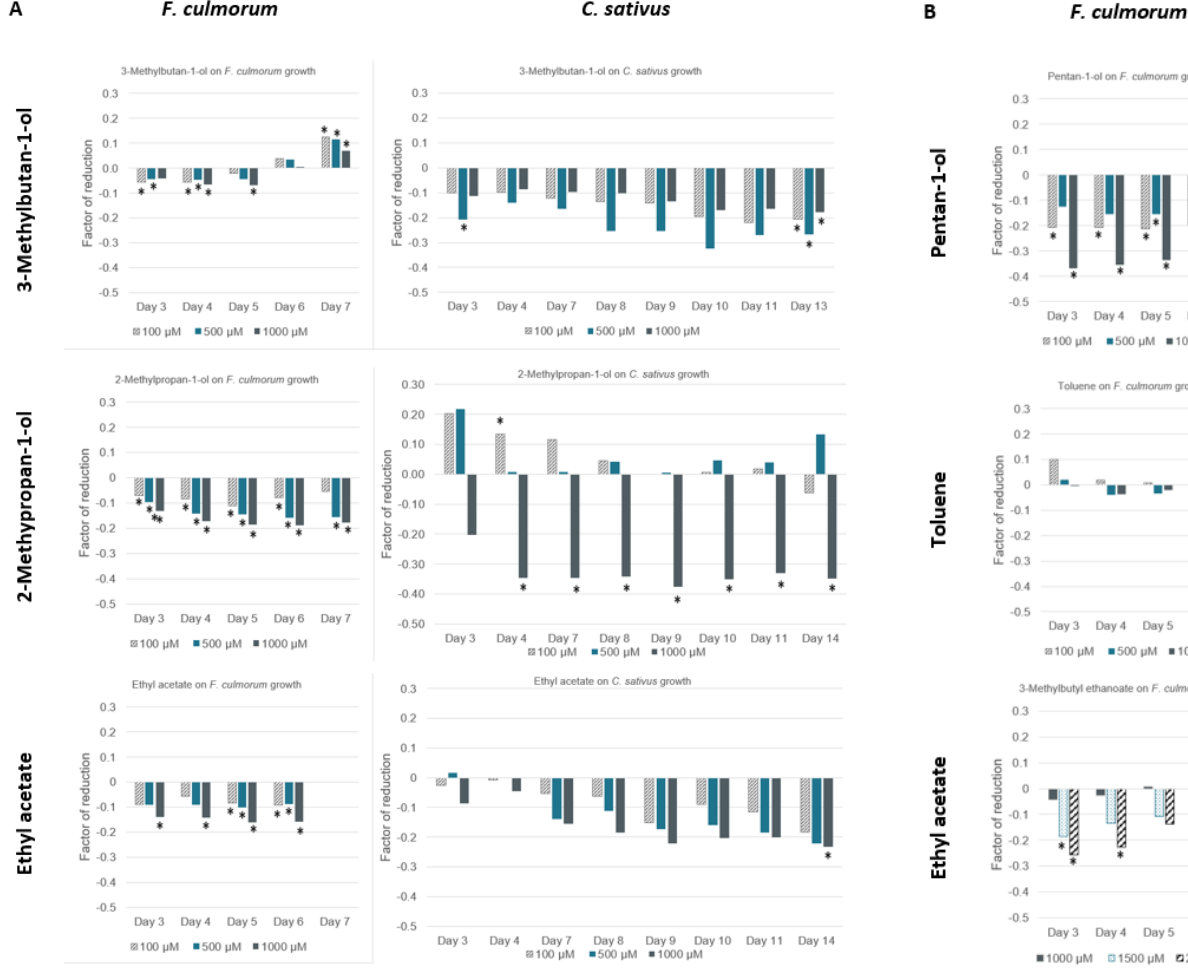
Figure 7. Factor of reduction of the growth of F. culmorum and C. sativus in the presence of individual VOCs at different concentrations over time ( A ): VOC tested commonly against the two species; ( B ): only against F. culmorum ; ( C ): only against C. sativus . * Means statistically significant results.